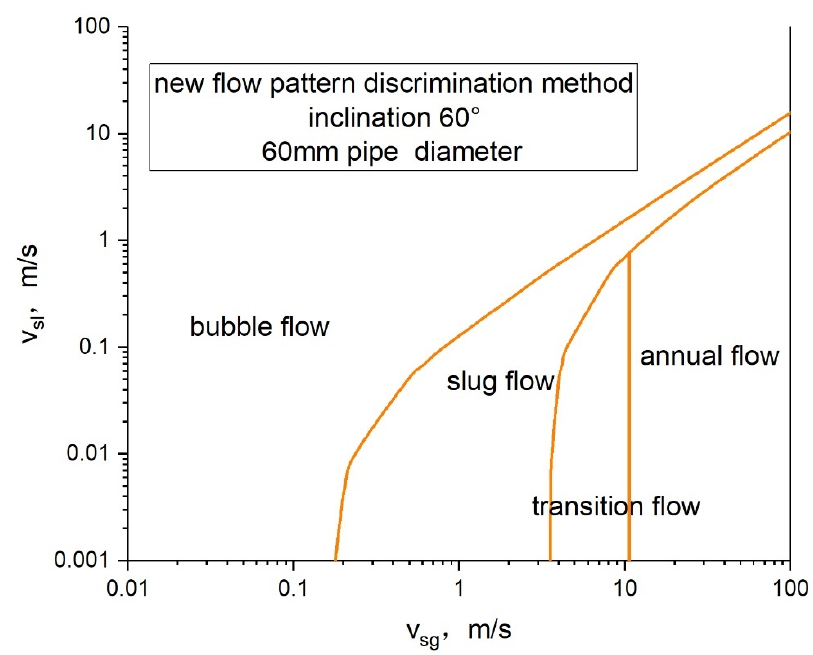
Figure 9. New discrimination method under 60° inclination.